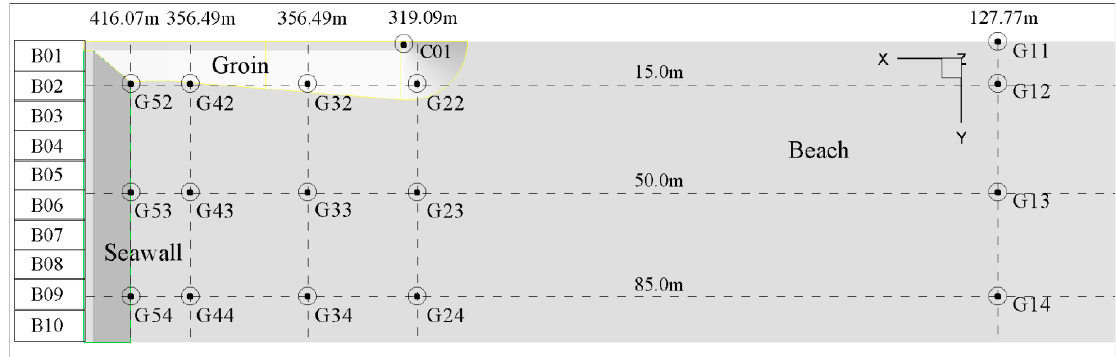
Figure 18. Free surface gauges inside the wave tank (G11 to G54) and overtopping gauges on the crest head groin (C01) and the crest breakwater (B01 to B10).